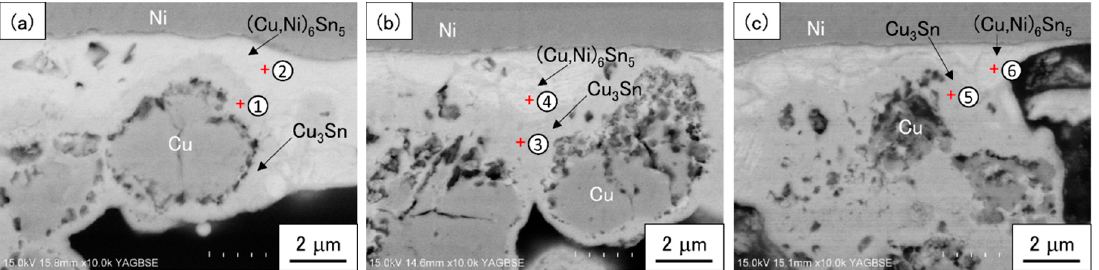
Figure 9. Cross-sectional SEM images of the interfaces between the bonding layer and chip aged at ( a ) 150, ( b ) 175, and ( c ) 200 °C for 1000 h. Table 2. Chemical composition (at.%) in the marked areas in Figure 9 measured by EDX spectroscopy. Aging